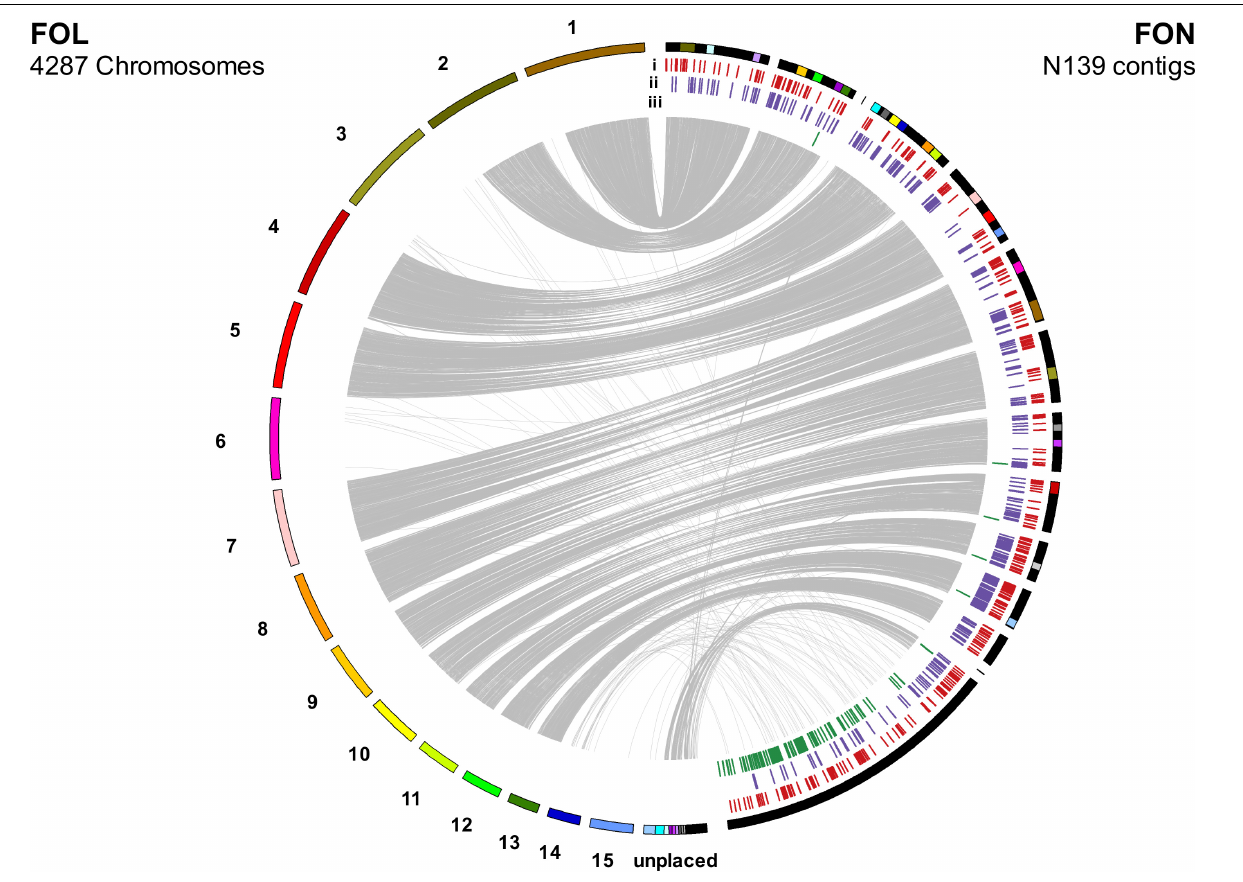
FIGURE 5 | Synteny between FOL and FON genomes as determined by linking single copy orthologous genes. The 14.9 Mb of FON contigs not showing synteny with FON chromosomes are grouped following syntenous contigs. Annotation tracks under FON contigs show distribution of: (i) secreted genes with an effector-like structure, (ii) secreted carbohydrate active enzymes and (iii) mimps throughout the